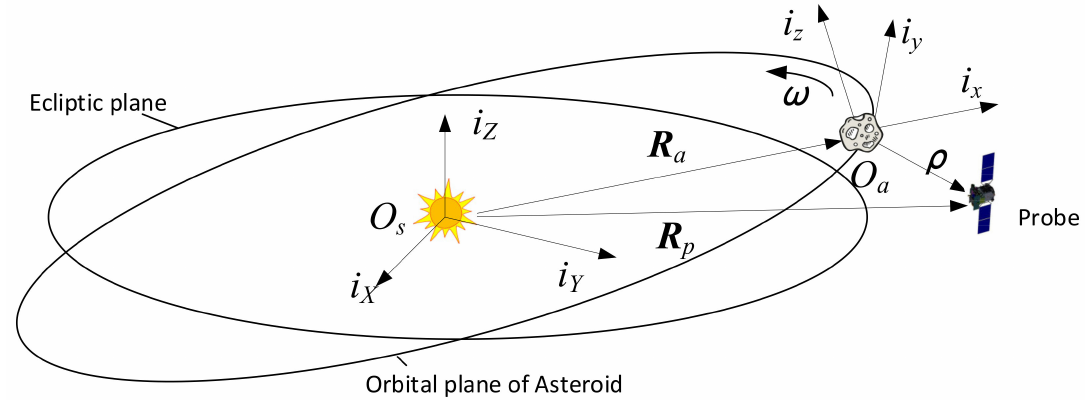
Figure A1. Definition of asteroid Hill rotation coordinate